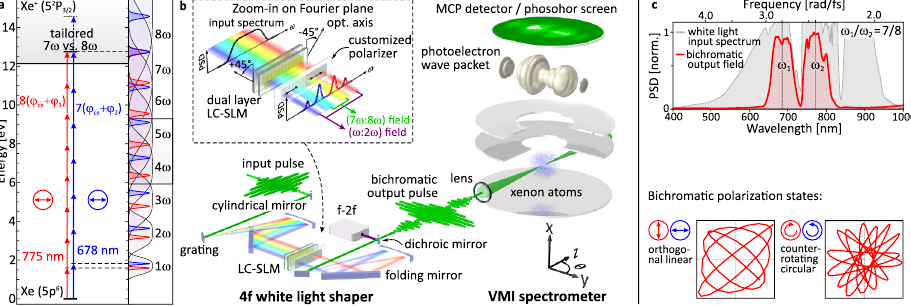
Figure 1. Excitation scheme of xenon (Xe) atoms for bichromatic 7- vs. 8-photon ionization (a) [6]. Experimental setup (b) [6]. Spectral amplitude profile of the (7 ω :8 ω ) field (red) sculptured out of the octave-spanning WLS (gray shaded) (c) [6]. The panels below show two examples for accessible spatial polarization profiles, measured via shaper-based parametric cross-correlation trajectories [3, 5]. So far, ( ω :2 ω ) fields have been generated by superimposing a fundamental pulse and its second harmonic. In this case, the CEP dependence of induced multiphoton ionization